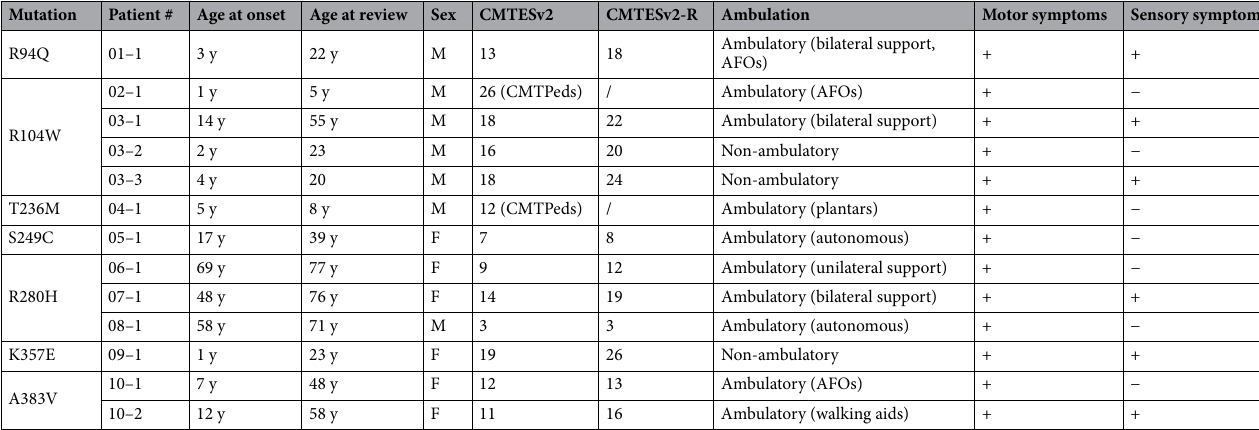
Table 1. Phenotype and clinical severity of patients with MFN2 mutations. AFO ankle–foot orthosis, CMTES Charcot–Marie–Tooth examination scale, CMTES-R Rasch analysis-weighted CMTES, CMTPeds CMT Pediatric